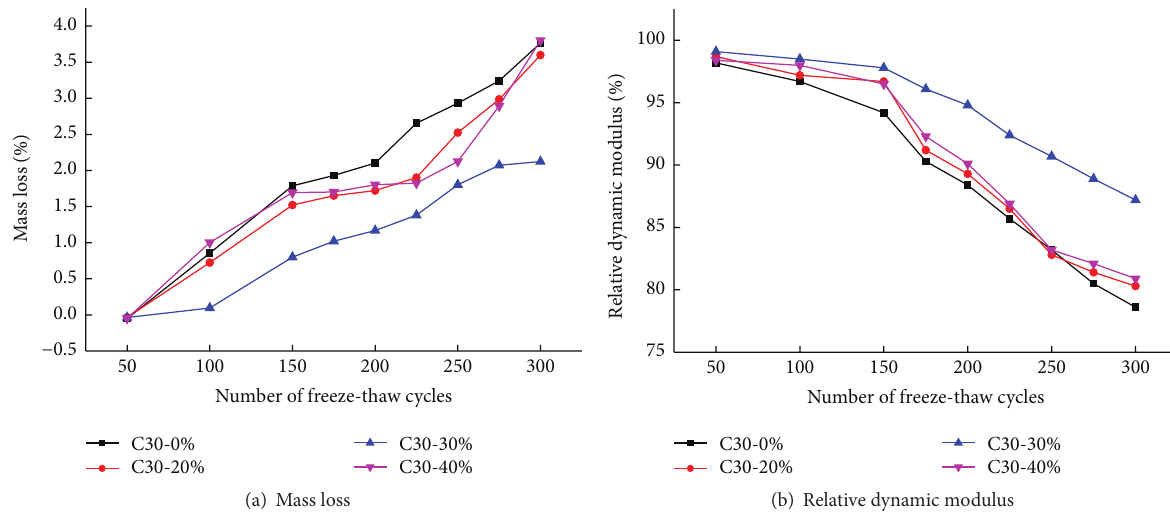
Figure 8: The antifrost performance of C30 concrete under water freeze-thaw